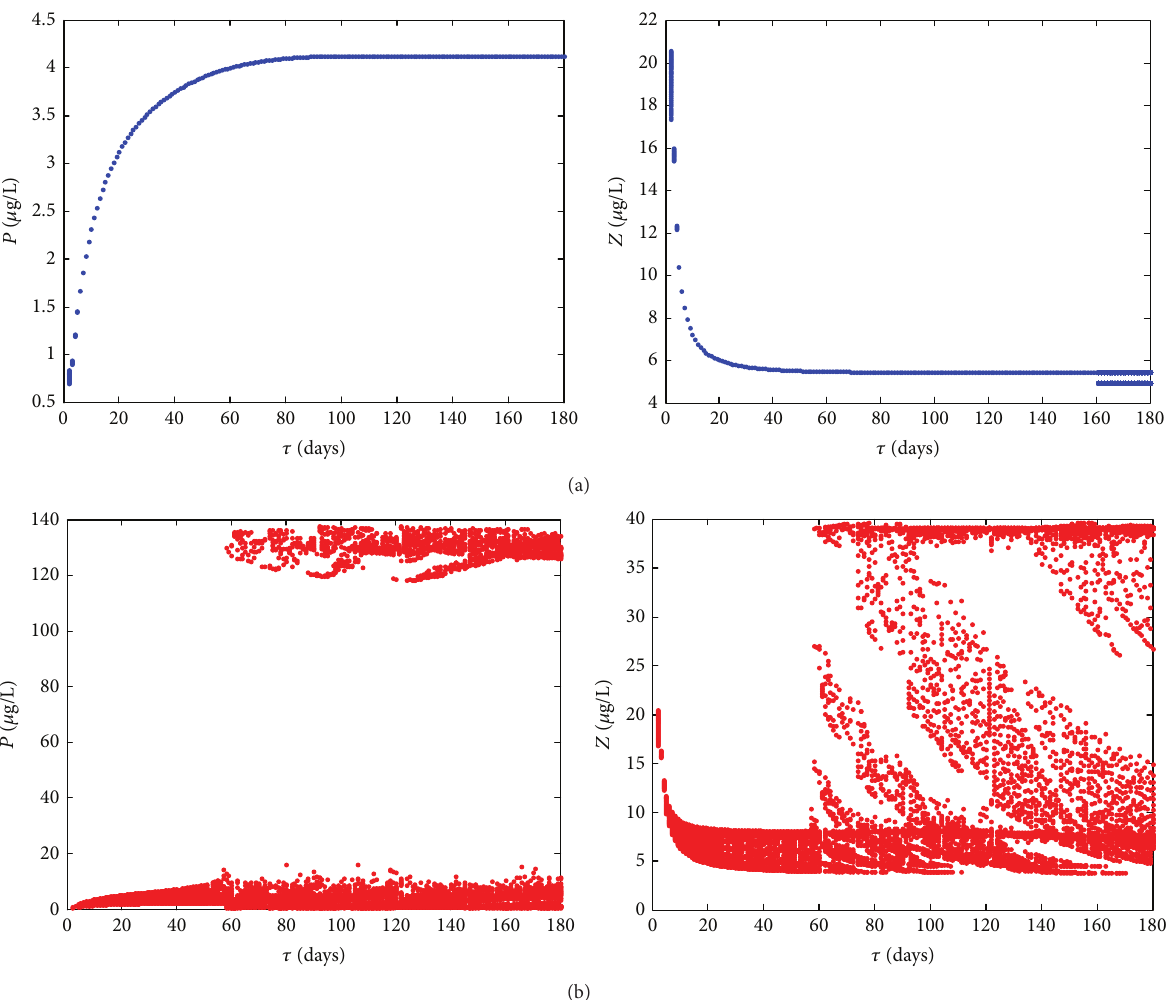
Figure 3: Bifurcation diagrams of system (3) without (a) and with (b) seasonally varying phytoplankton growth rate when 2 ≤ 𝜏 ≤ 180